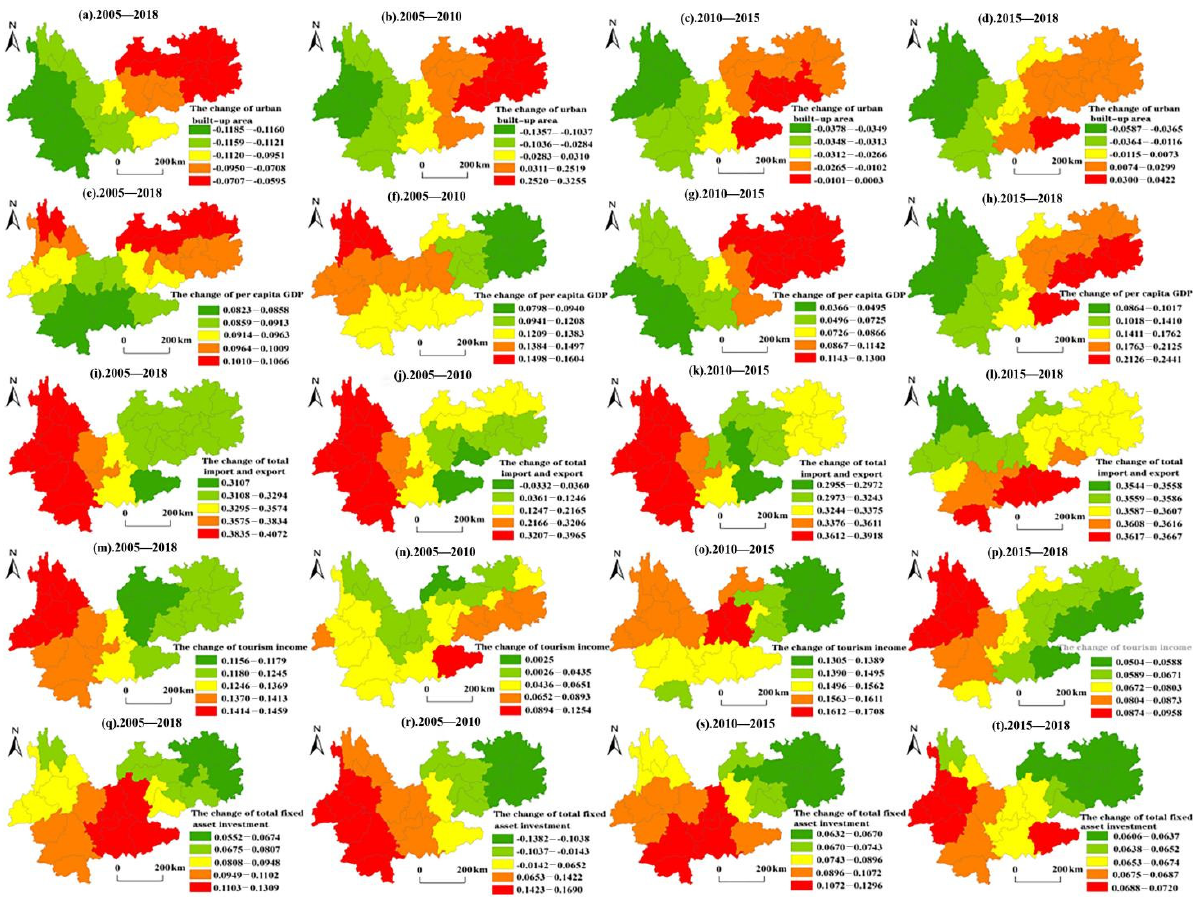
Figure 5. Spatial distribution of the regression coefficients for the GWR models, at different time periods.